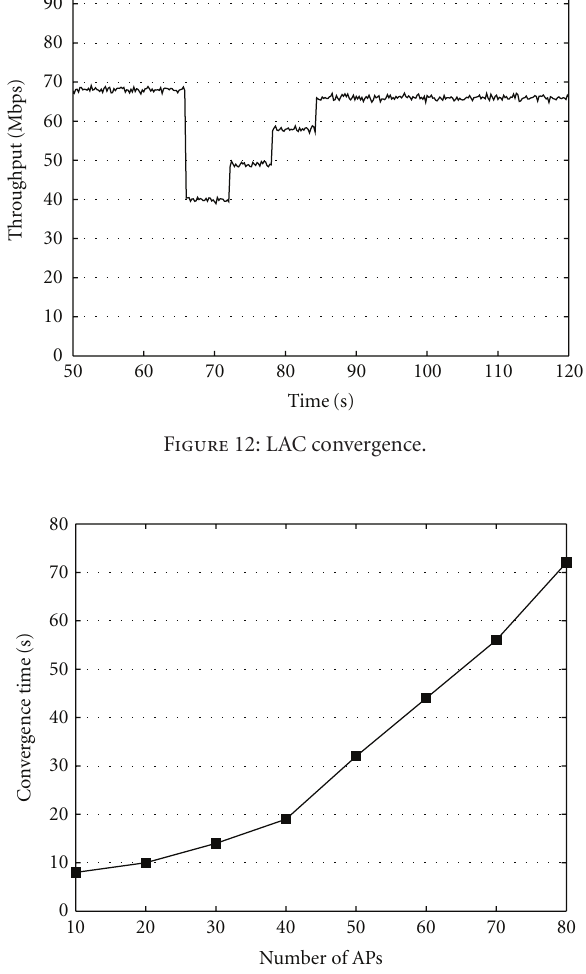
Figure 13: Convergence time versus number of APs.